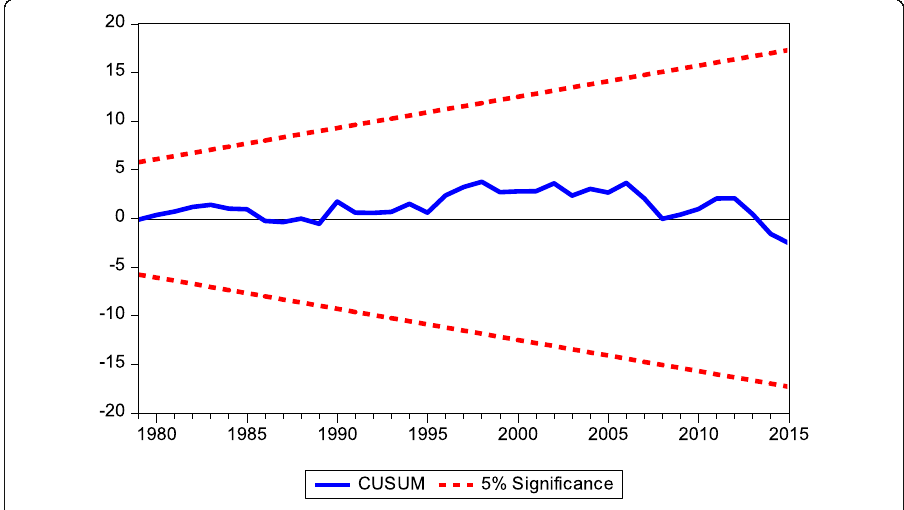
Fig. 1 Plot of Cumulative Sum of Recursive